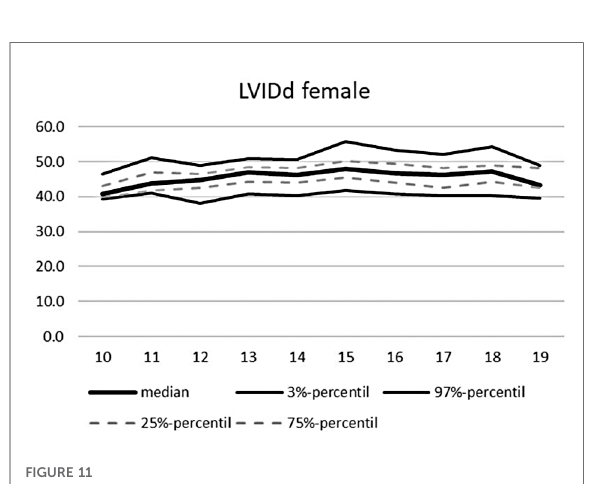
FIGURE 11 Echocardiographic values in dependence of age, LVIDd females.